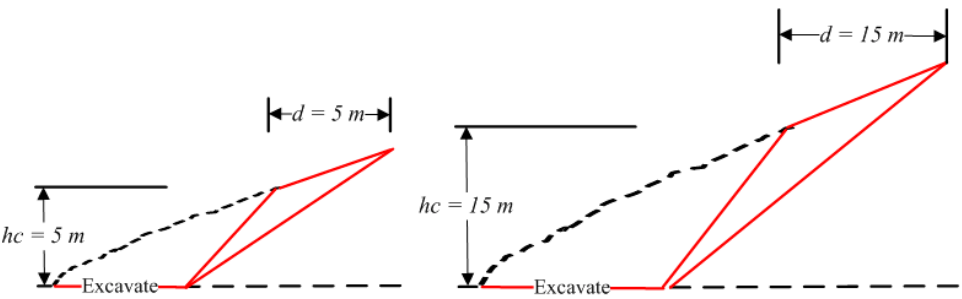
Figure 3. Schematic diagram for slip surface of slope excavation.